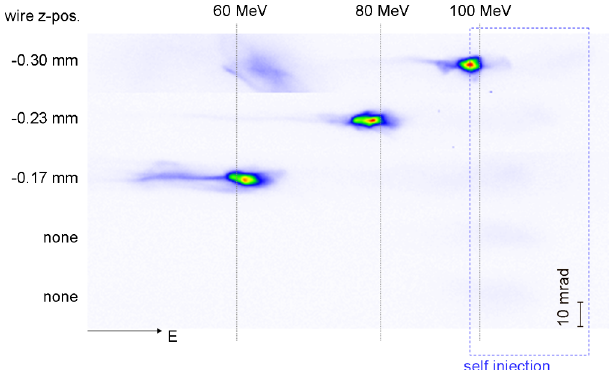
FIG. 3. Example spectra with comparable charge and variable wire position as recorded on the Lanex screen using 9.5 bar backing pressure. Besides the rather strong peak when the wire is present, a weak background self-injection can be seen in all spectra.